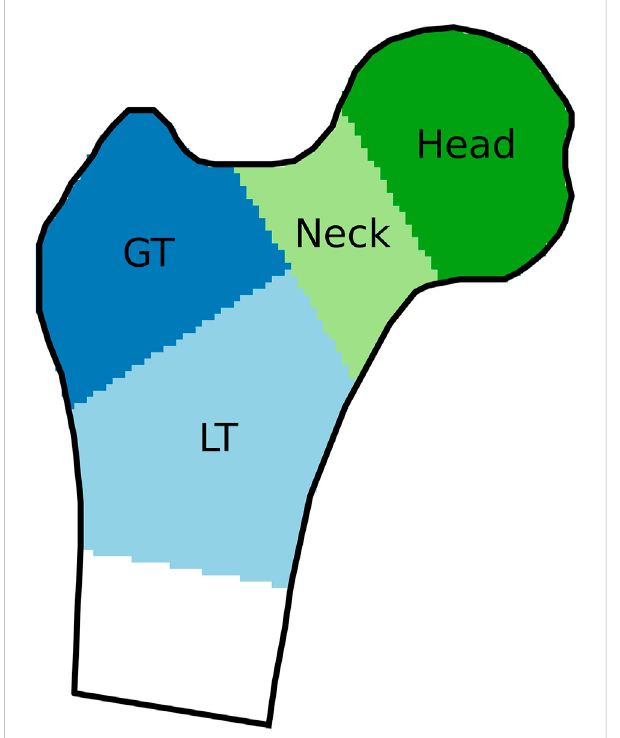
FIGURE 2 Regions of interest, indicated on a coronal cross-section of a proximal femur. GT and LT stand for greater and lesser trochanter, respectively. FIGURE 3